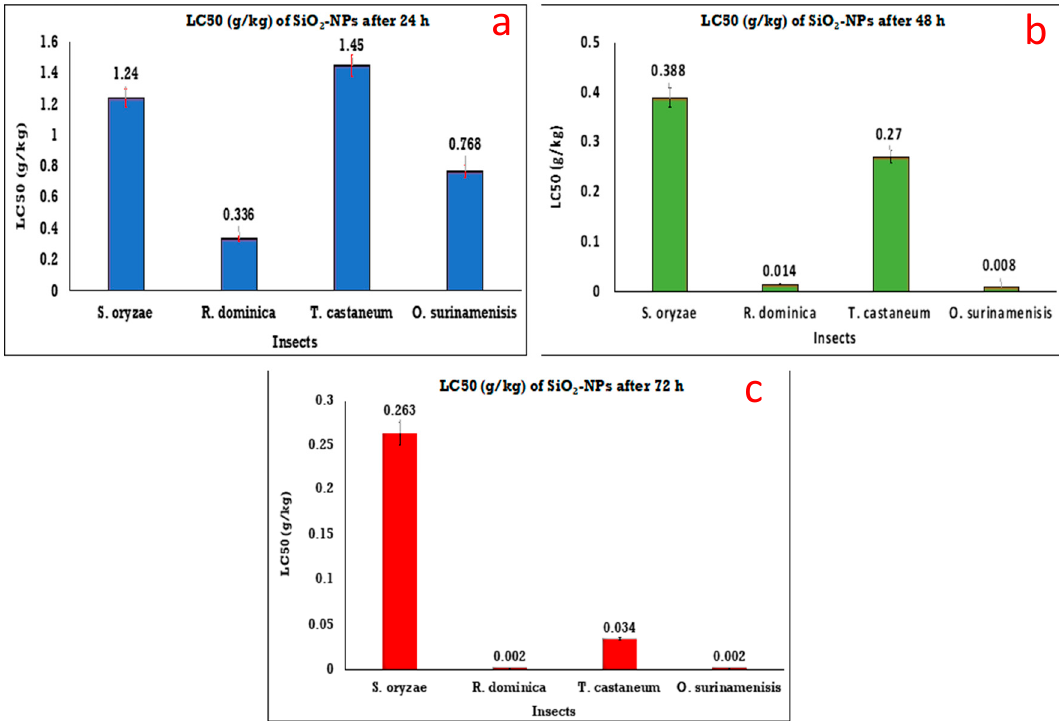
Figure 7. Insecticidal activity of the Nano silica (SiO 2 -NPs) against S. oryzae , R. dominica , T. castaneum and O. surinamenisis as recorded ( a ) after 24 h; ( b ) after 48 h and ( c ) after 72 h.